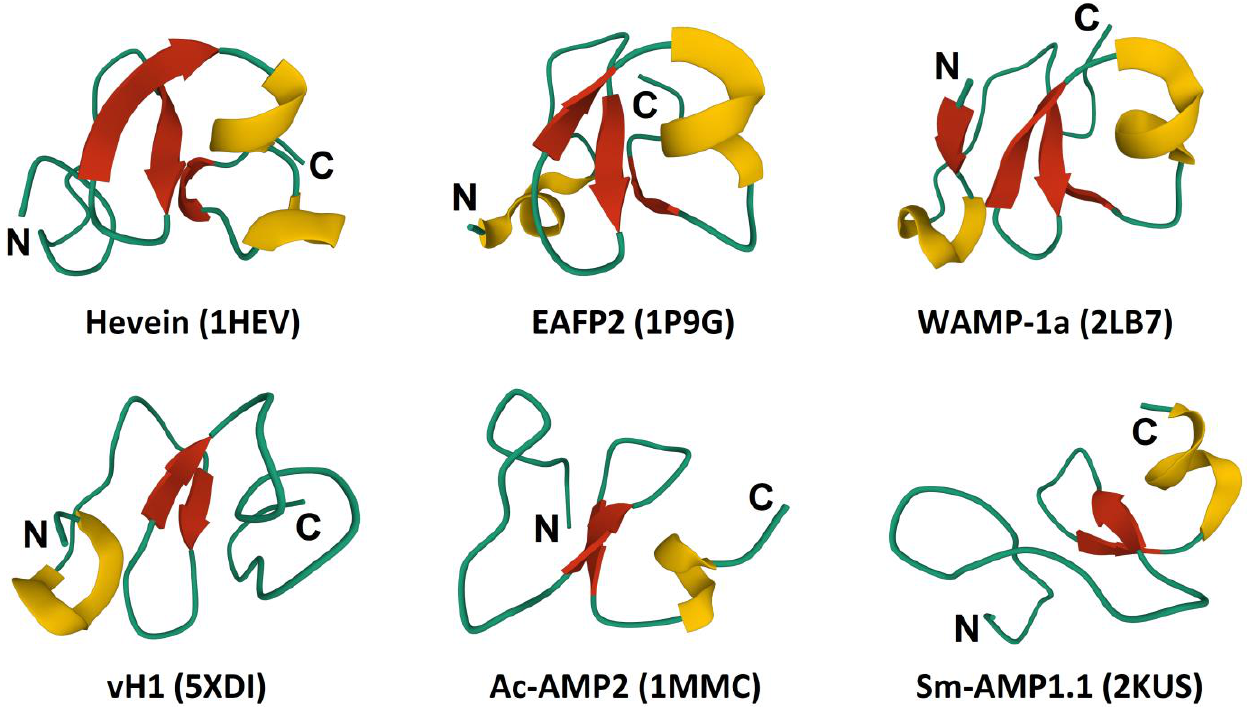
Figure 4. 3D structure of hevein-like peptides. The helices are colored yellow, and the β -structures are colored red. The N- and C-termini are indicated by N and C, respectively.